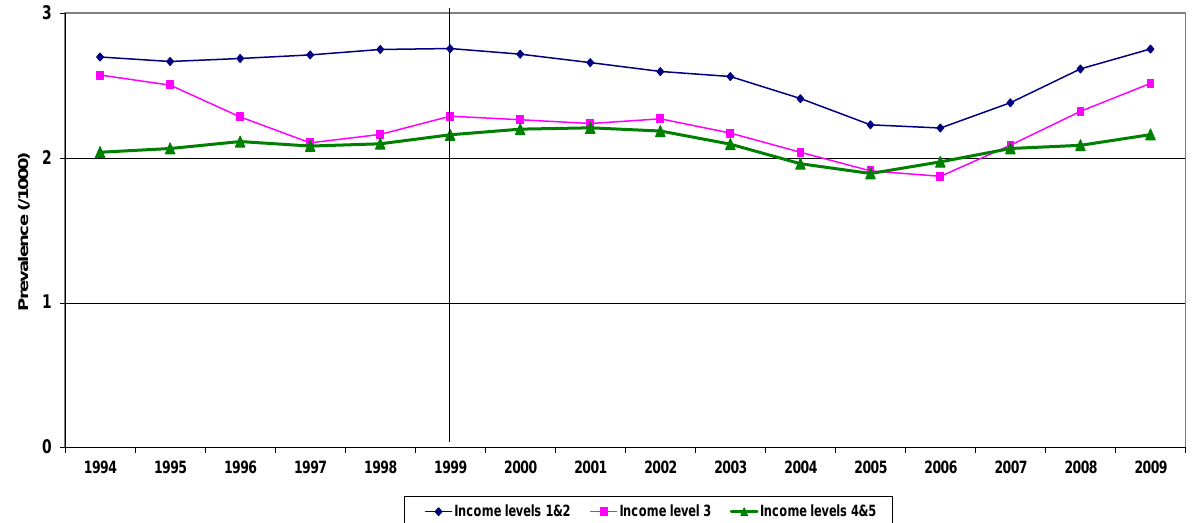
Vertical line indicates the onset of food fortification with folic